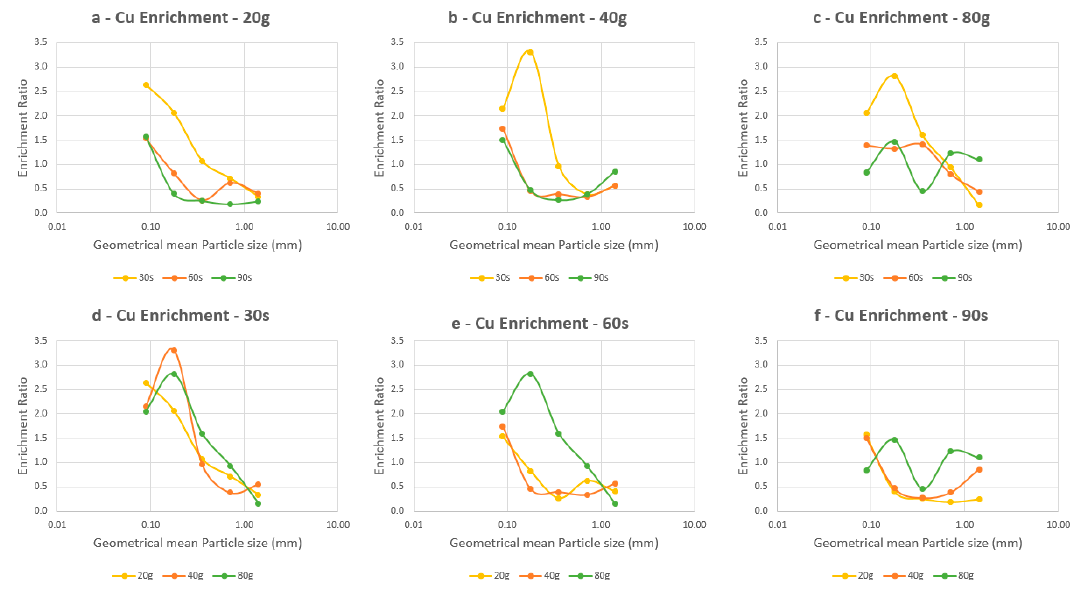
Figure 7. Cu enrichment ratio after hammer milling as a function of feed mass, milling time and particle size. Feed Size 1–2 mm. ( a ) 20 g feed, ( b ) 40 g feed ( c ) 80 g feed, ( d ) 30 s milling time, ( e ) 60 s milling time, and ( f ) 90 s milling time. Experimental data points are connected with lines for the purpose of visual aid only.